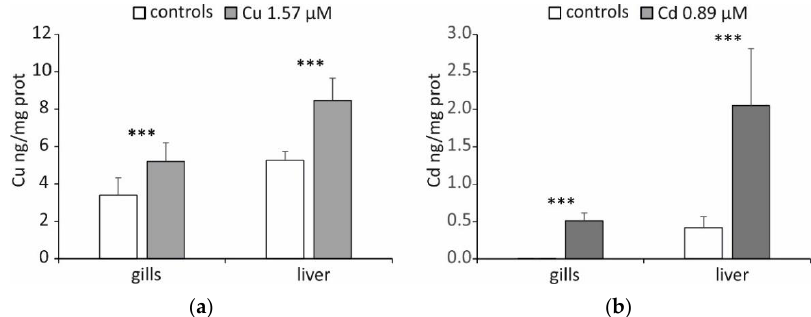
Figure 1. ( a ) Cu and ( b ) Cd concentrations (ng/mg of total proteins) determined in the gills and liver of T. hansoni . Data are reported as the mean of five specimens ± SD. Asterisks indicate differences between controls and treated specimens ( p < 0.001).